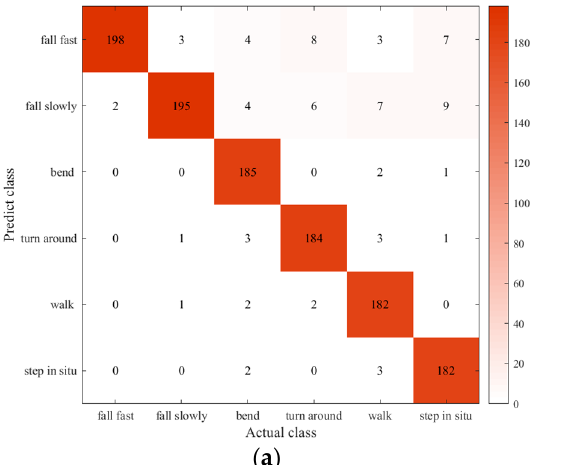
Figure 16. ROCs of three different mechanisms. Table 6. AUC obtained from three different mechanisms.